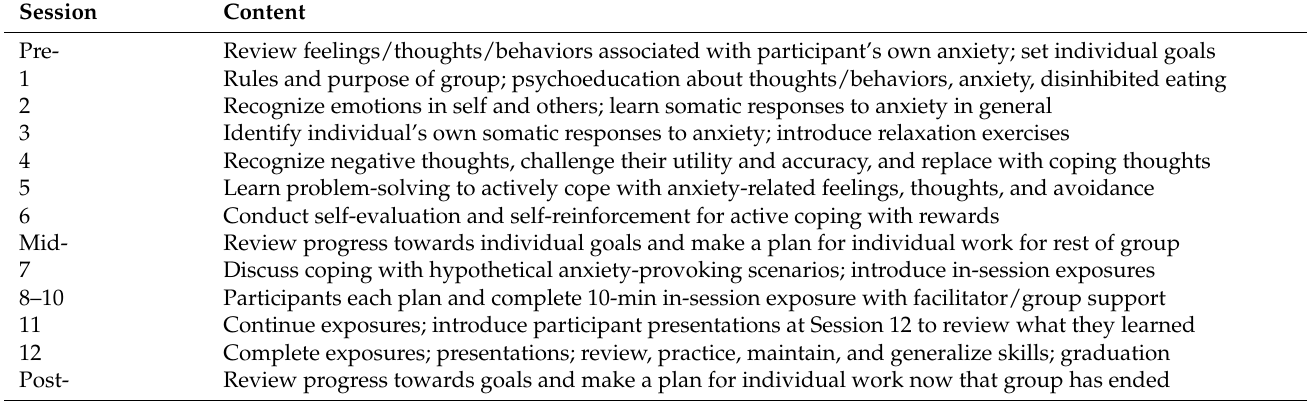
Table 2. Summary of CBT session